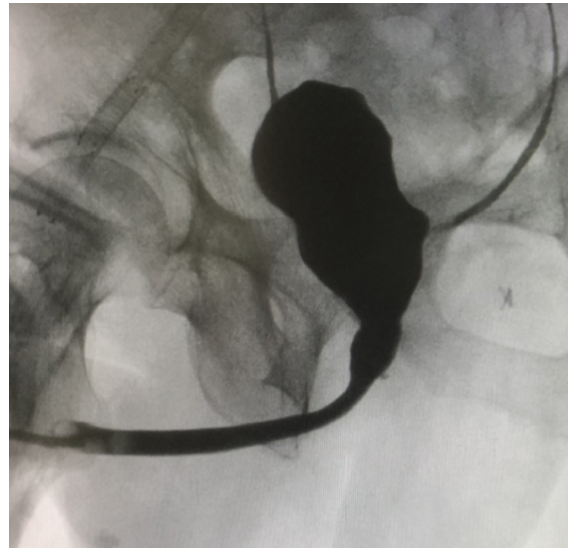
Figure 5. Urethrogram 6 months after urethral reconstruction.